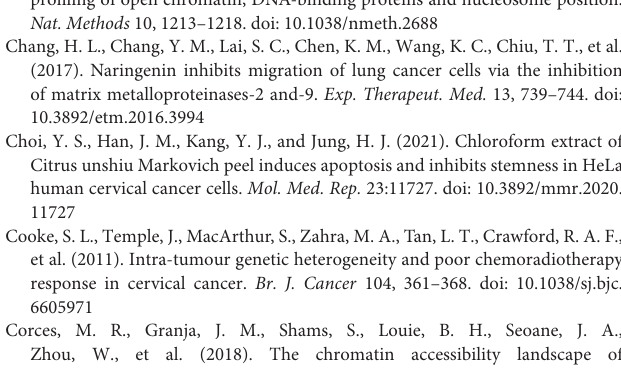
Supplementary Figure 1 | Volcano plot for DEGs between 19 cervical cancer patients with positive lymph nodes (N + ) and 20 patients with negative (N0) (A) . Bar plot for gene sets over-representation analysis of DEGs and significant hallmark pathways (B)